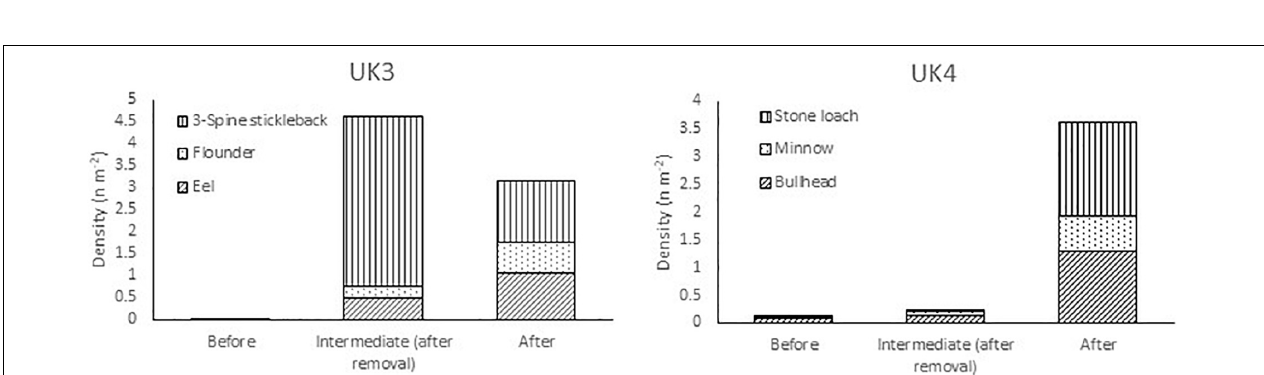
FIGURE 5 | Salmonid (brown trout, Salmo trutta and Atlantic salmon, S. salar ) density at seven Danish (DK) sites which showed an increase in fish density following barrier removal. Note density scale varies between graphs. Error bars 95% CI.